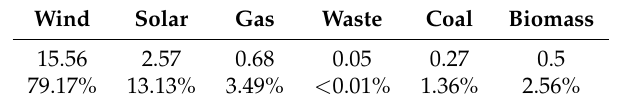
Figure 1. Reference power grid in Schleswig-Holstein with installed capacities. Table 1. Installed capacity by carriers (GW) provided by the data of [10] from [14].